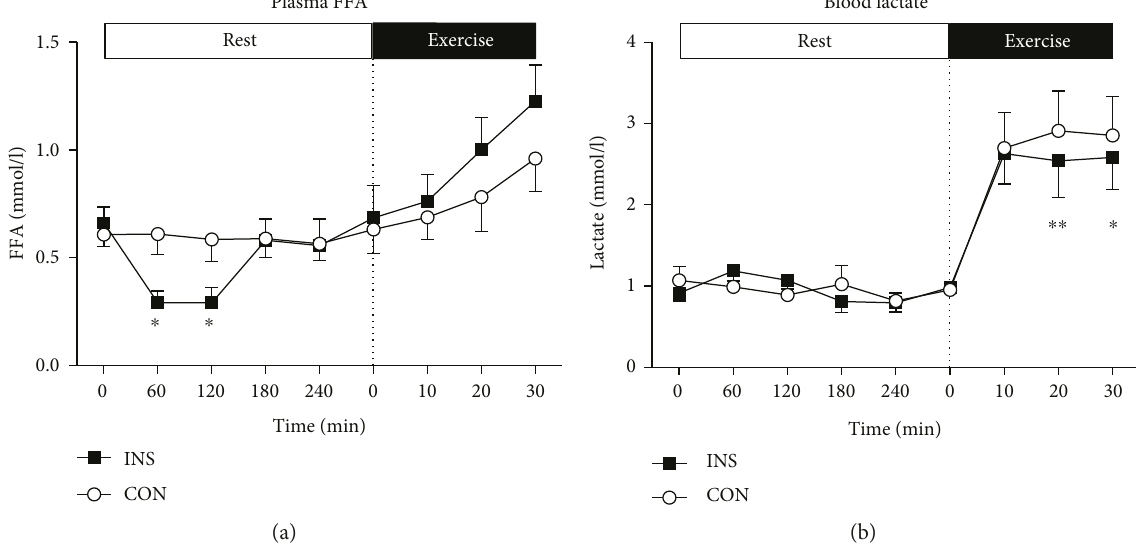
Figure 2: Plasma FFA (a) and blood lactate (b) concentrations during the INS and CON trials. Data represent n =6, mean ± SEM. (a) At rest, there were signi fi cant time ( P < 0 001 ) and interaction ( P < 0 05 ) e ff ects, where plasma FFA were suppressed in INS. During exercise, there was a signi fi cant time e ff ect ( P < 0 001 ) and a trend ( P = 0 085 ) for an interaction e ff ect, where plasma FFA in INS increased to greater extent than that in CON. (b) At rest, there was no signi fi cant e ff ect of the insulin infusion or time on blood lactate, although there was a signi fi cant interaction e ff ect ( P < 0 01 ). During exercise, there were signi fi cant time ( P < 0 001 ) and interaction ( P < 0 05 ) e ff ects, where the blood lactate response was lower in INS than that in CON. ∗ P < 0 05 from CON; ∗∗ P < 0 01 from